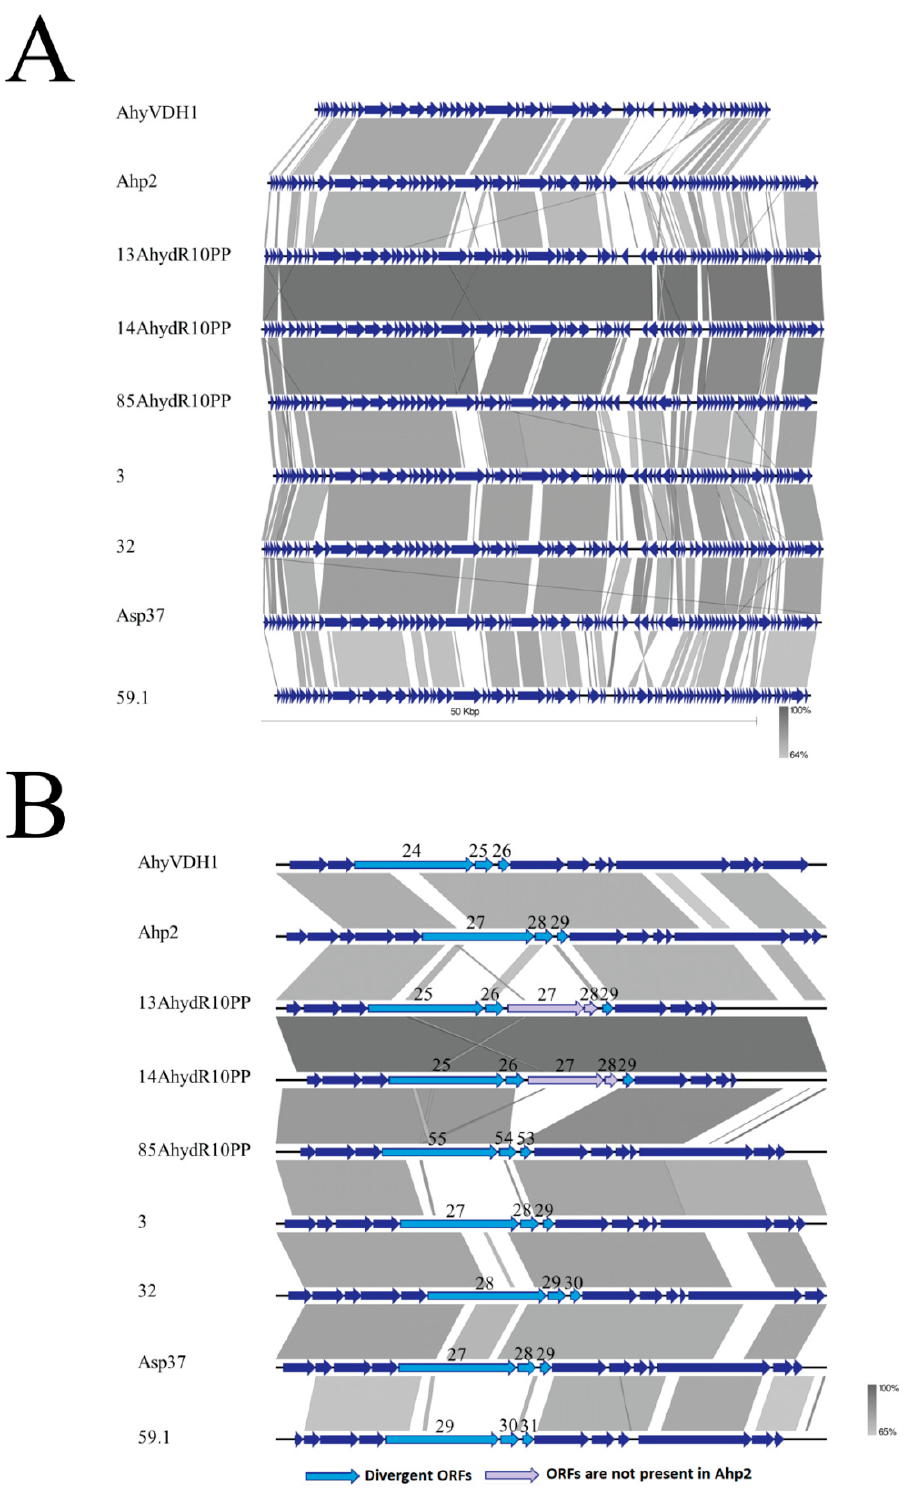
Figure 4. Comparison of the phage genomes. ( A ) The whole genome and ( B ) the region containing the ORF27-ORF29 orthologs are illustrated and compared. The genomes of Ahp2 and A. hydrophila phages (AhyVDH1, 13AhydR10PP, 14AhydR10PP, 85AhydR10PP) and A. salmonicida phages (3, 32, Asp37, 59.1) were aligned and compared using EasyFig. The identity cutoff was 64%. Number indicates the ORF number of the phages.